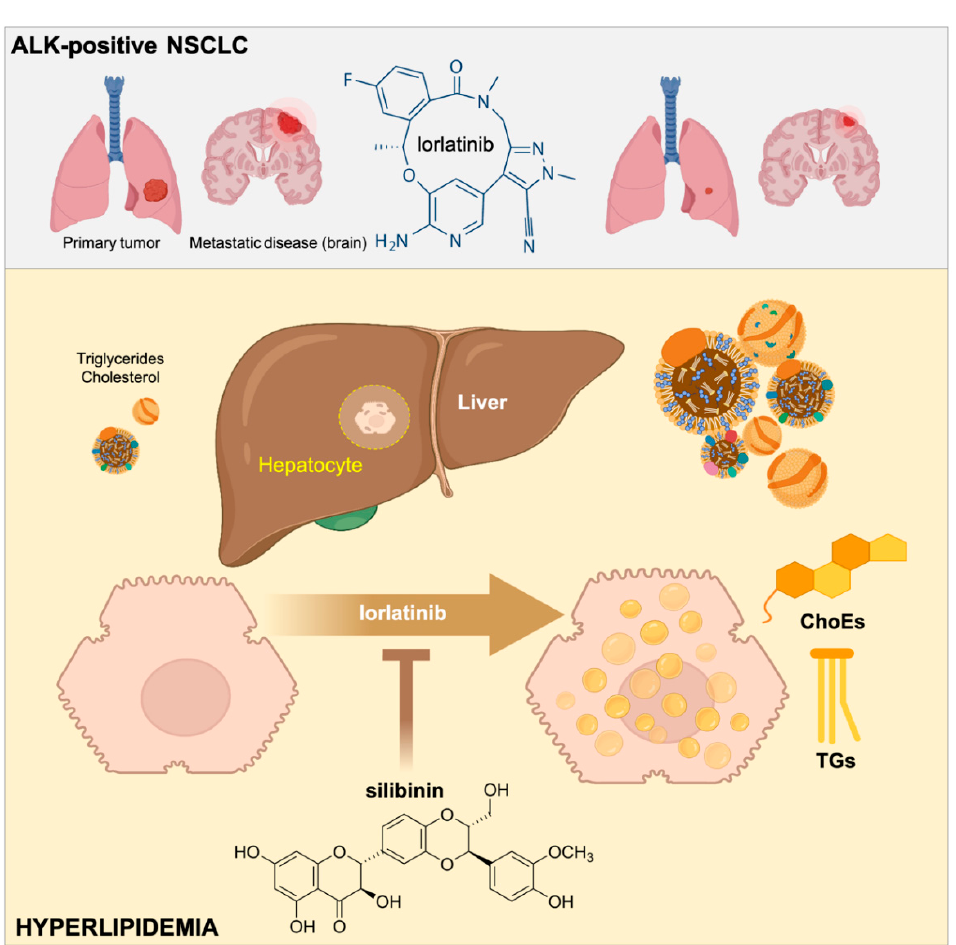
Figure 6. Silibinin suppresses the hyperlipidemic effects of lorlatinib in hepatic cells. The third generation ALK-TKI lorlatinib promotes the accumulation of cholesterol and triglycerides in human hepatic cells. The flavonolignan silibinin protects hepatic cells against the hypertriglyceridemic and hypercholesteremic effects of lorlatinib. Silibinin is a new candidate to clinically manage the undesirable hyperlipidemic activity of lorlatinib in patients with ALK-rearranged lung cancer. Lorlatinib is rapidly absorbed to achieve peak plasma concentrations of >2 μ mol/L 0.5–4 h after a single 100 mg oral dose and is widely distributed in different tissues [46,47], with the highest concentration found in the liver [48]. The hepatic accumulation of lorlatinib can be explained in terms of its low metabolism in this organ, with only 12% of lorlatinib metabolized during first-pass hepatic metabolism or pre-systemic metabolism. We show that acute exposure to a clinically relevant concentration of lorlatinib (1 μ mol/L) promotes a rapid and significant buildup of cholesteryl esters and tri-/di-glycerides in he- patic cells. We also found that longer exposure to lorlatinib drives the hallmarks of hepatic steatosis, such as the abnormal and excessive accumulation of neutral lipids in liver cells. While our study was not designed to investigate the precise molecular mechanisms in- volved in the hepatic alterations in cholesterol and triglycerides homeostasis in response to lorlatinib, it is reasonable to suggest that there is overlap in the targeted pathways for ALK-rearranged NSCLC growth and those that regulate hepatic function, leading to on- target or closely related off-target hepatic toxicity. It will be critical to understand the mechanistic pathways by which lorlatinib induces a dysregulation of lipid and cholesterol metabolism in hepatic cells. Because one of the major mechanisms of drug-induced liver injury (including TKIs such as lorlatinib) centrally involves mitochondrial perturbation and dysfunction [49,50], mitochondria might be viewed as a probable target through which lorlatinib alters lipid metabolism in human hepatocytes. Particularly, drugs